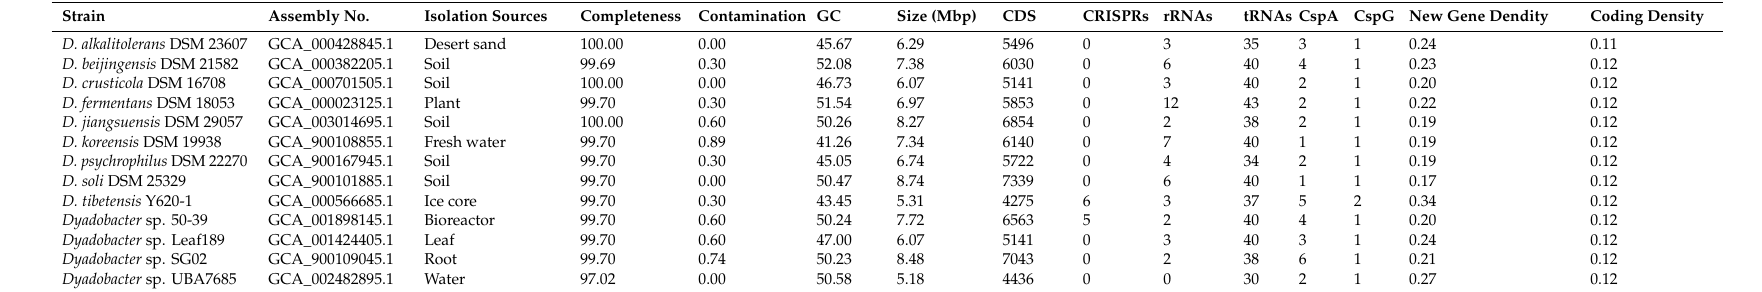
Table 1. Genomic and phenotypic characteristics of the 13 Dyadobacter strains with sequenced